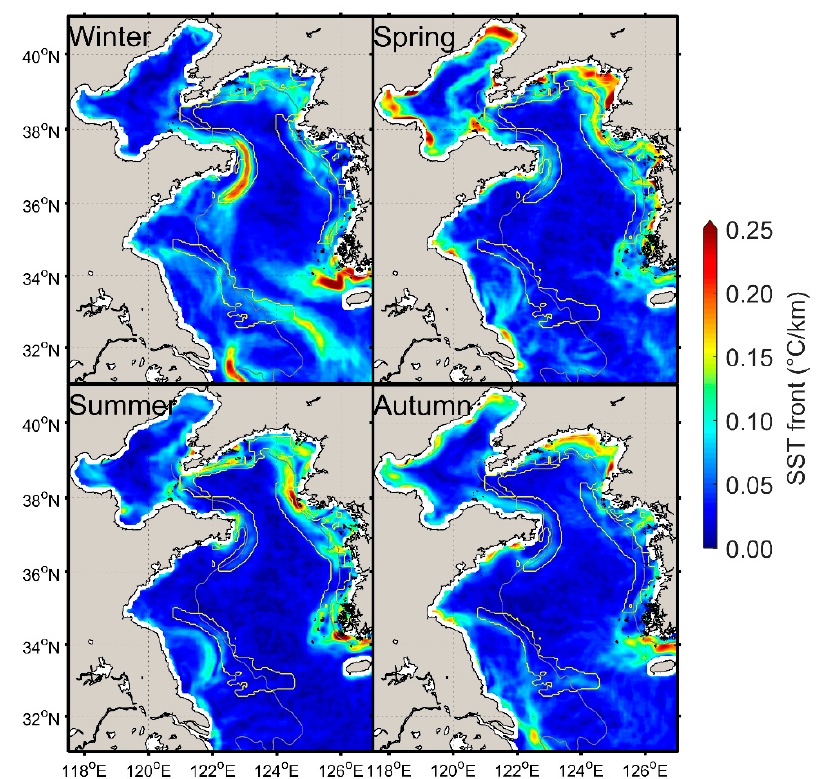
Figure 7. Seasonal SST front magnitudes (°C/km). The yellow lines represent the five summer chl-a front outlines. The gray lines denote the 40 m isobath.